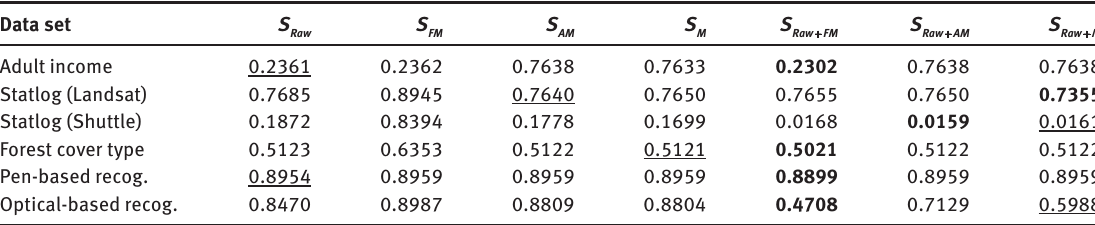
Table 7 presents the SVM misclassification rates on the six multiclass real-world data sets. For this group of data sets